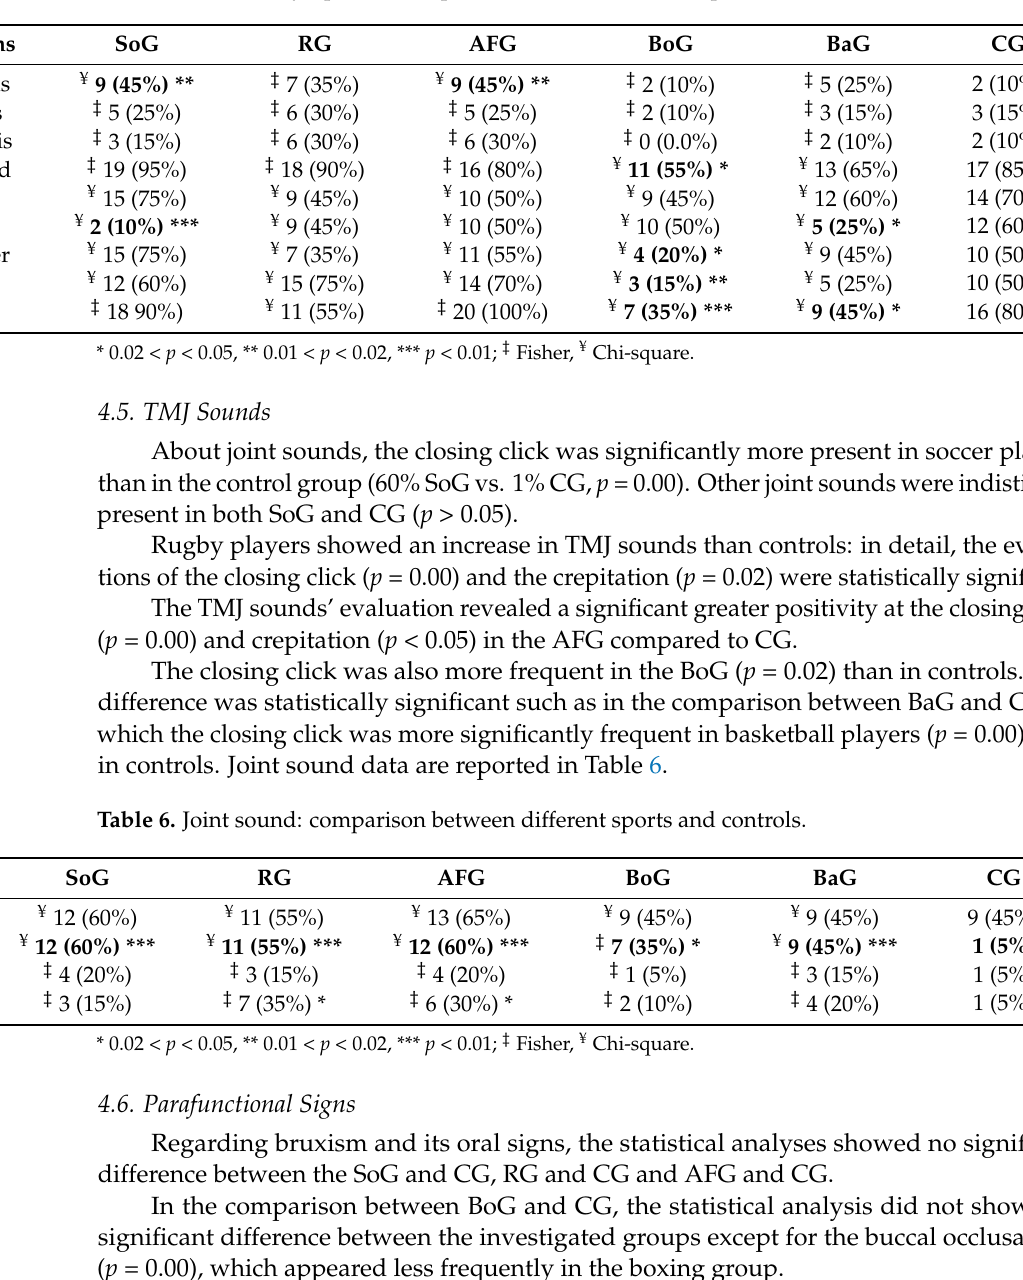
Table 5. Muscular symptoms: comparison between different sports and controls.